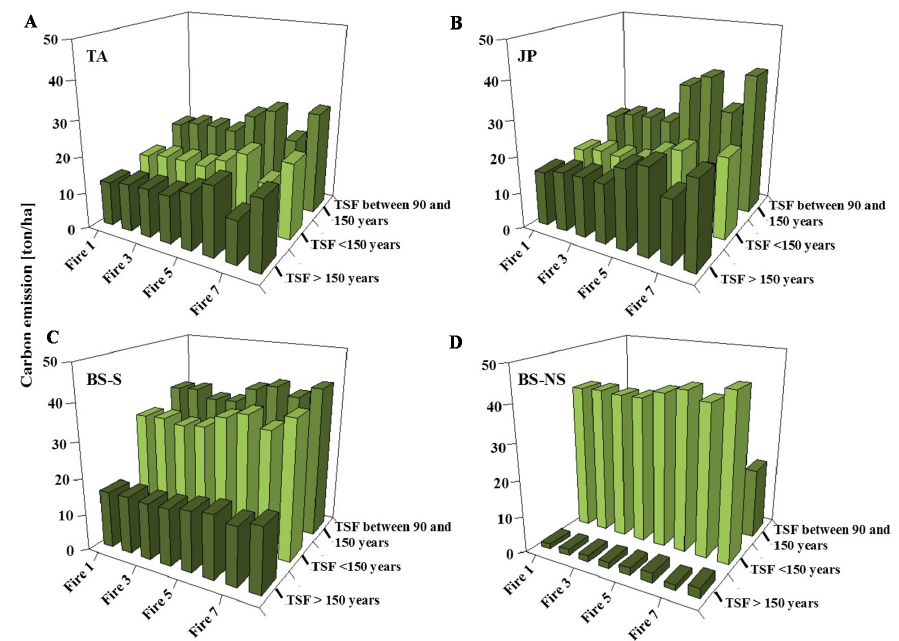
Figure B1. CanFIRE potential carbon emissions averaged by early (TSF < 90 years), intermediate (TSF between 90 and 150 years) and late (TSF > 150 years) successional stages, and by dominant forest types of the Clay Belt boreal landscape (( A ) trembling aspen (TA), ( B ) jack pine (JP), ( C ) black spruce originating from severe fire (BS ‐ S), and ( D ) black spruce originating from non ‐ severe fire (BS ‐ NS) forests). Simulations were performed using FWI System components for each natural fire start from 1971 to 2000.